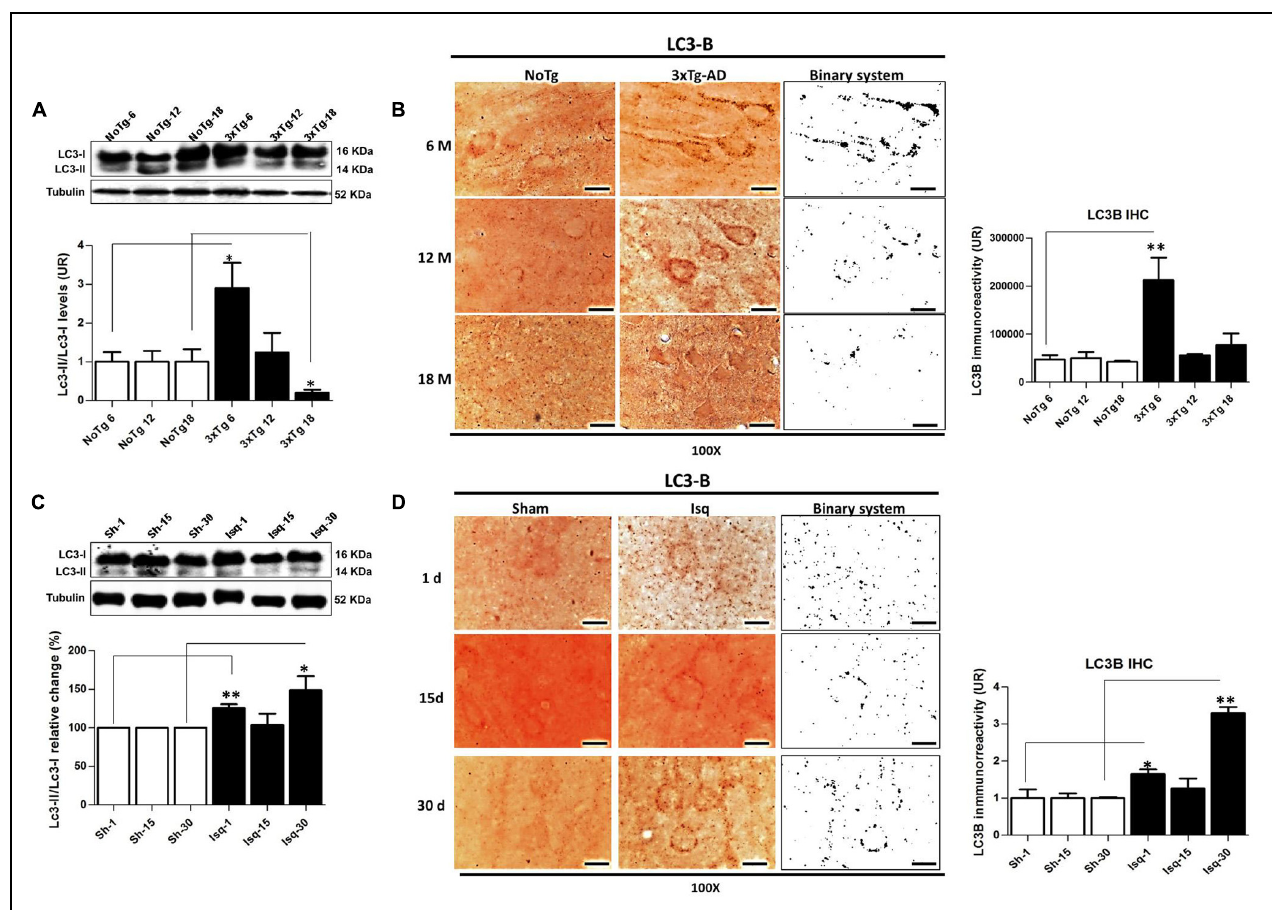
FIGURE 4 | LC3B immunoreactivity in the cerebral cortex of 3xTgAD mice and in cerebral ischemic rats. (A) Increase in the LC3B-II/LC3B-I ratio ( p ≤ 0.010) and (B) LC3B puncta formation at 6 months ( p ≤ 0.0013) in 3xTg-AD. (C) The LC3B-II/LC3B-I ratio was increased on day 1 ( p ≤ 0.0239) and at 30 days post-ischemia ( p ≤ 0.0032). (D) LC3B immunoreactivity puncta formation was increased at 1 ( p ≤ 0.0125) and 30 days ( p ≤ 0.0058) post-ischemia. The bands are representative of LC3B-I and LC3B-II in AD and